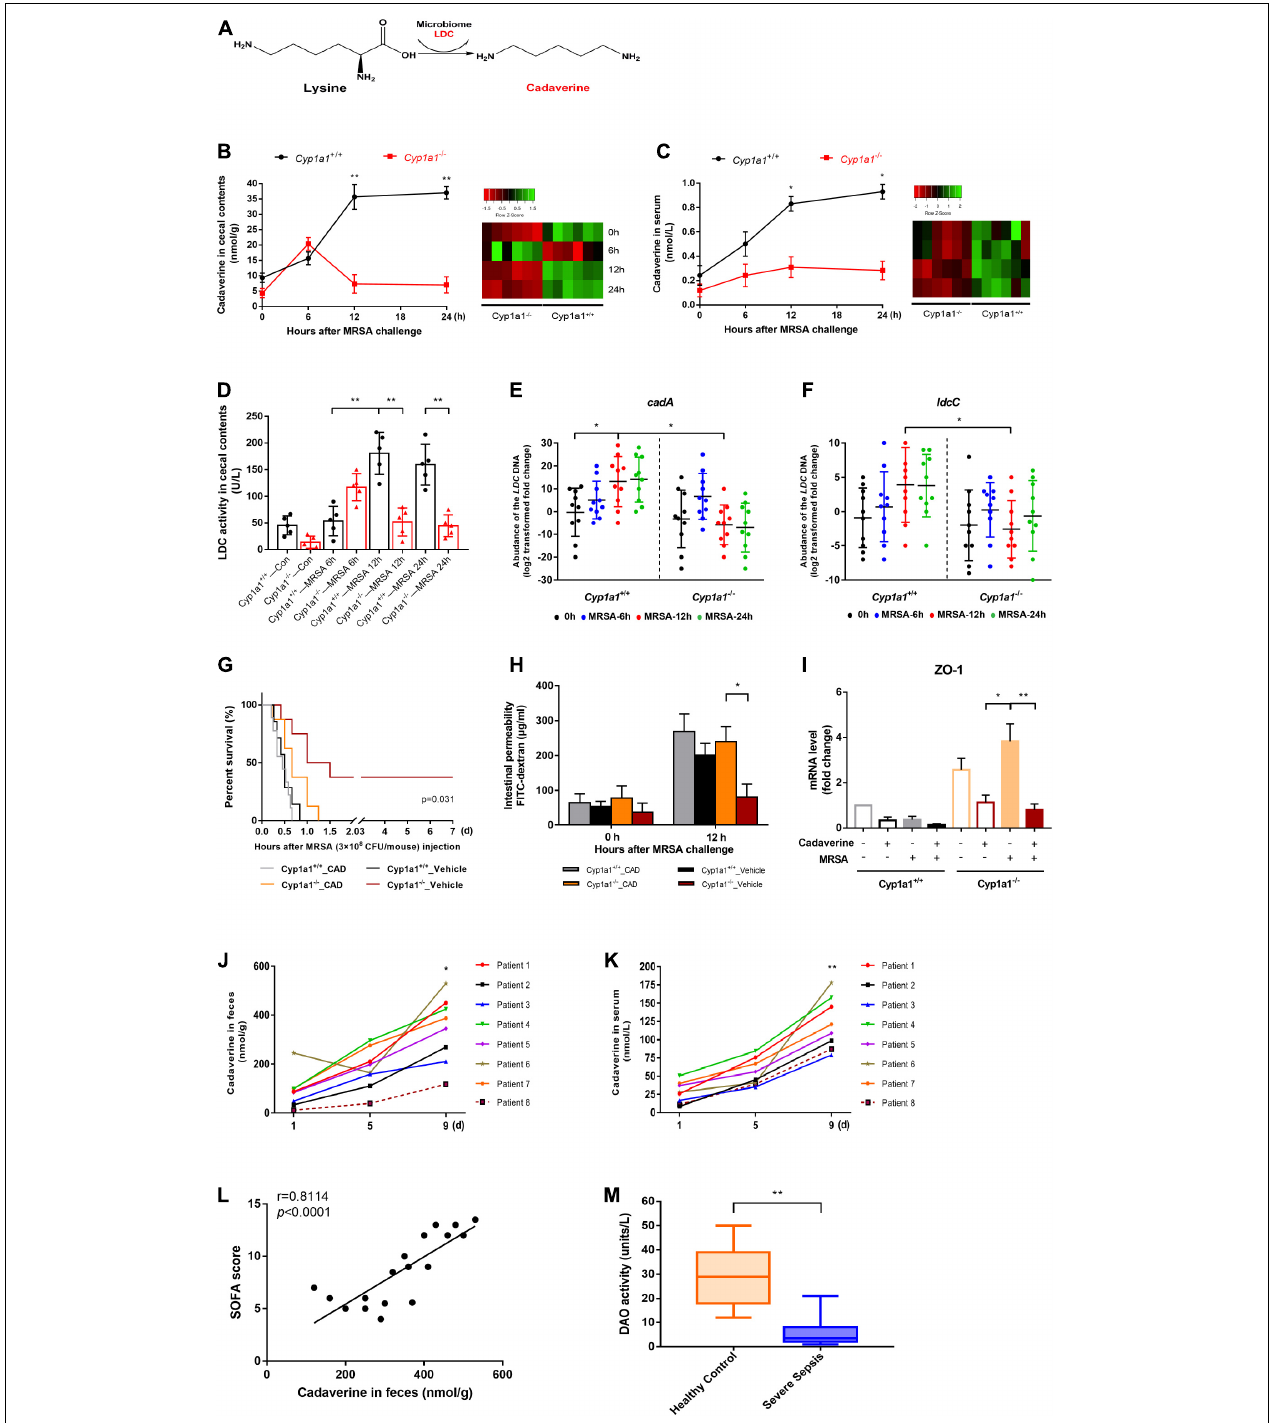
FIGURE 3 | Caecal cadaverine is elevated during MRSA-induced sepsis. (A) Schematic diagram of cadaverine (CAD) biosynthesis from L -lysine. CAD levels in (B) the caecal contents and (C) serum ( n = 9) were measured by UHPLC–MS following MRSA challenge. (D) Lysine decarboxylase (LDC) enzyme activity and RT–qPCR analysis of (E) cadA and (F) ldcC within caecal DNA samples. CAD administration to Cyp1a1 − / − mice led to (G) reduced survival; (H) a higher FITC-dextran concentration in serum, and (I) reduced mRNA expression of ZO-1 in the ileal epithelium, as shown by RT–qPCR. CAD levels in (J) feces and (K) serum from patients with sepsis and MRSA infection ( n = 8). (L) Correlation between the fecal CAD level and sequential organ failure assessment (SOFA) score. The Spearman correlation coefficient was used for evaluation. (M) Serum diamine oxidase (DAO) enzyme activity from patients with sepsis and MRSA infection ( n = 18) and healthy controls ( n = 20). Error bars, ± SEM. * P < 0.05, ** P <